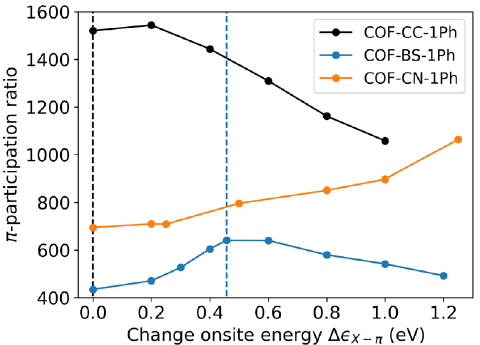
Figure 13. Changes in the delocalization of π -states (measured by the participation ratio with disorder 0.5eV ) upon shifting the linker’s onsite-energy. Vertical dashed lines indicate where onsite energies W = for linker and phenyl rings would coincide, i.e. 0 eV , for COF-BS-1Ph at �ǫ X- π �ǫ X- π =